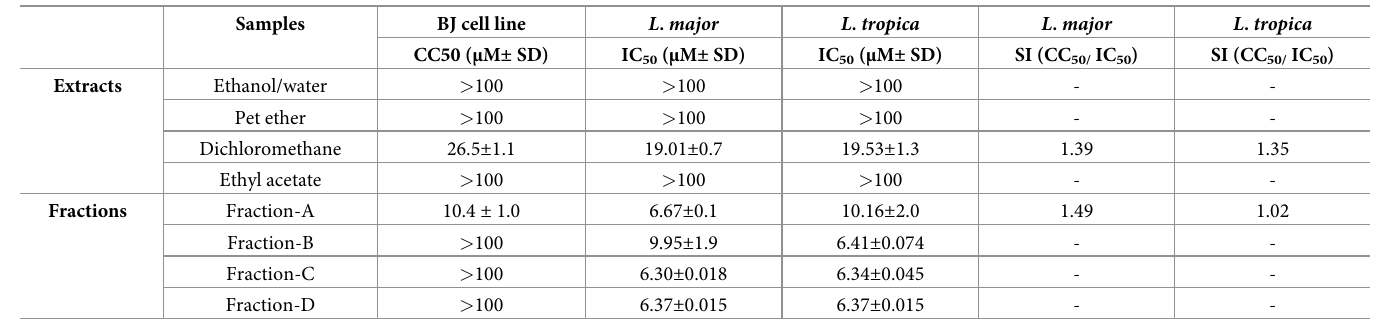
Table 4. Selectivity index of pure compounds against BJ fibroblast cell line.